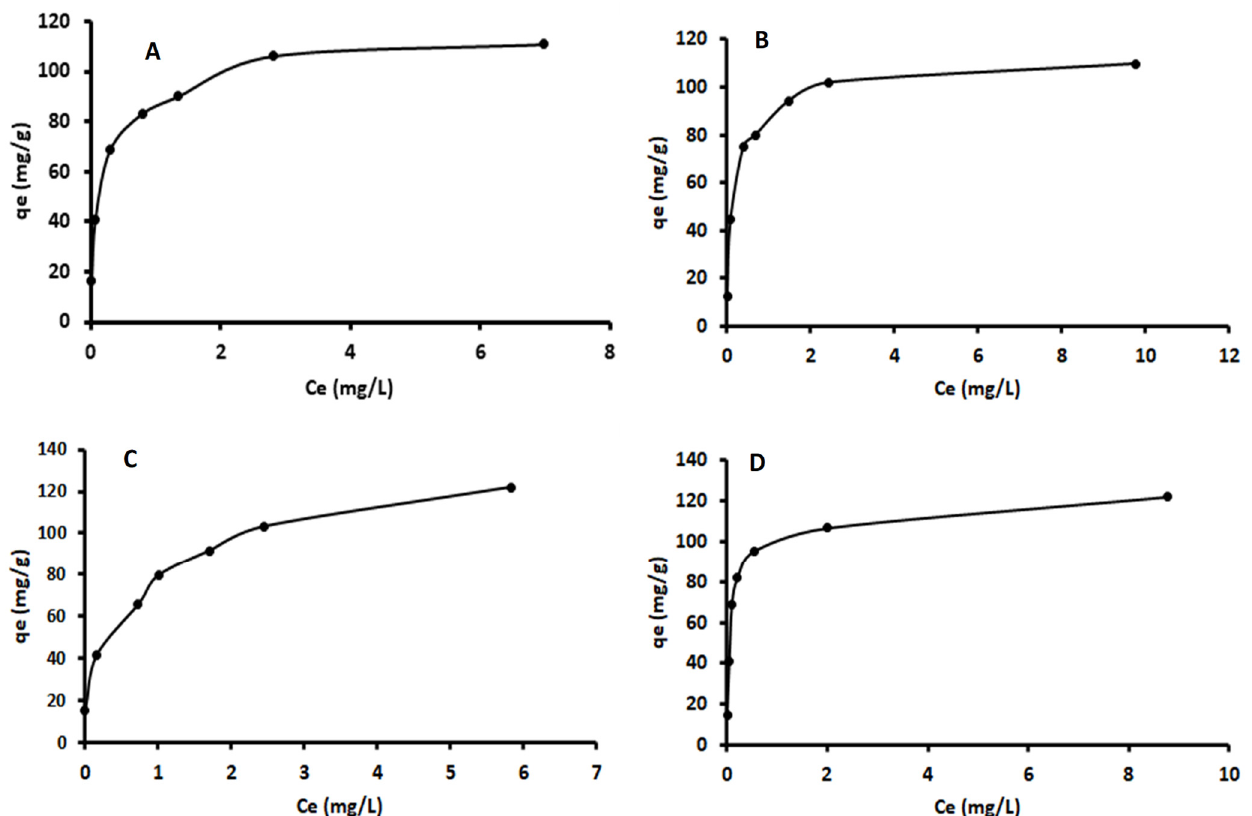
Figure 6. Adsorption of ( A ) Cd, ( B ) Cu, ( C ) Ni and ( D ) Mn onto Fe 3 O 4 -ZrO 2 @APS adsorbent.